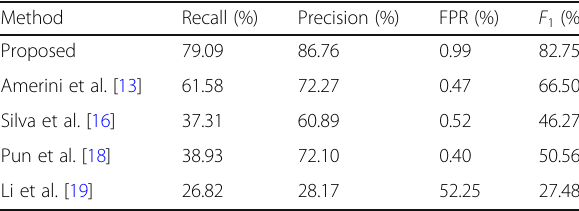
Table 7 Detected results for D2 dataset under resizing Method